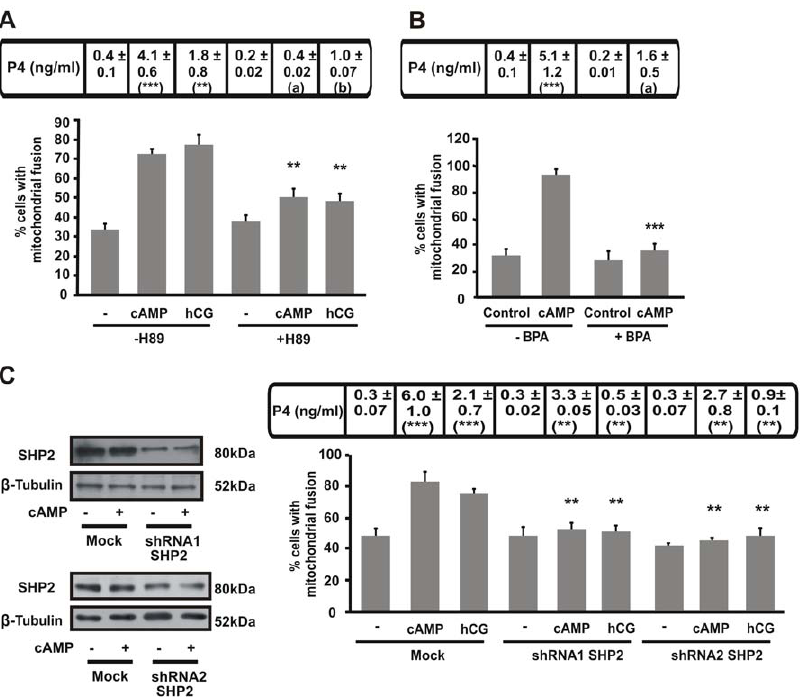
Figure 5. PKA activity induces mitochondrial fusion in steroid synthesis. MA-10 cells were transfected with mt-YFP and 24 h post- transfection treated as described for each panel. For each point, 100 cells were scored and mitochondrial shapes were classified. Quantitative analysis of fused mitochondria was shown. A. Cells were treated with or without H89 (20 m M) and stimulated with hCG (20 ng/ml) or 8Br-cAMP (1 mM) for 1 h. The results are expressed as the means 6 SEM of three independent experiments. ** P , 0.01 vs. 8Br-cAMP without H89. B. Cells were treated with or without BPA (20 m M) and 8Br-cAMP (1 mM) for 1 h. The results are expressed as the means 6 SEM of three independent experiments. *** P , 0.001 vs. cAMP without BPA. C. Left panel: MA-10 cells were transfected with a plasmid containing different shRNA SHP2 (shRNA1 or shRNA2). After 48 h, total proteins were obtained and western blotting was performed. Membranes were sequentially blotted with anti-SHP2 and anti- b -tubulin antibodies. An image of a representative western blot is shown to assess shRNA1 and 2 knockdown efficiency. Right panel: cells were transfected with the plasmid combination, the mt-YFP-empty vector, mt-YFP-shRNA1 or mt-YFP-shRNA2 and after 48 h, cells were fixed and mitochondrial shape scored. The results are expressed as the means 6 SEM of three independent experiments. ** P , 0.01 vs. cAMP mock. * P , 0.05 vs. hCG mock. Cellular medium was used to determine P4. Results of P4 measurement are indicated at the top of each graph as the means 6 SEM of three independent experiments. *** P , 0.001 vs. control. ** P , 0.01 vs. control, a P , 0.001 vs. cAMP without H89 or BPA and b P , 0.01 vs. hCG without